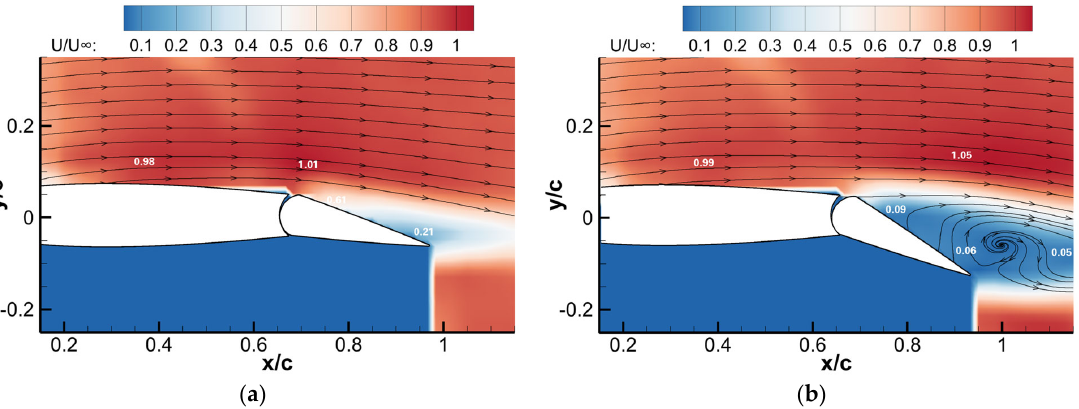
Figure 10. Velocity cloud diagram and streamline diagram of vertical tail upper surface without control: ( a ) δ = 15°; ( b ) δ = 30° ( β = 0°, Re = 2.12 × 10 5 ).